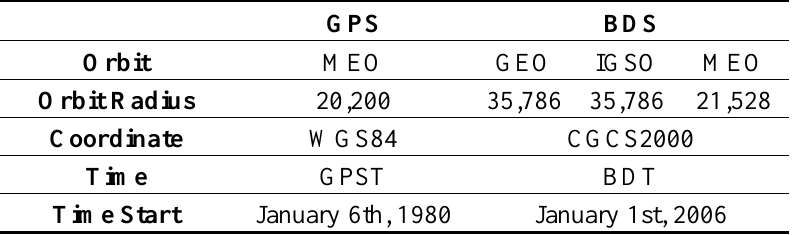
Table 1. Comparison of satellite